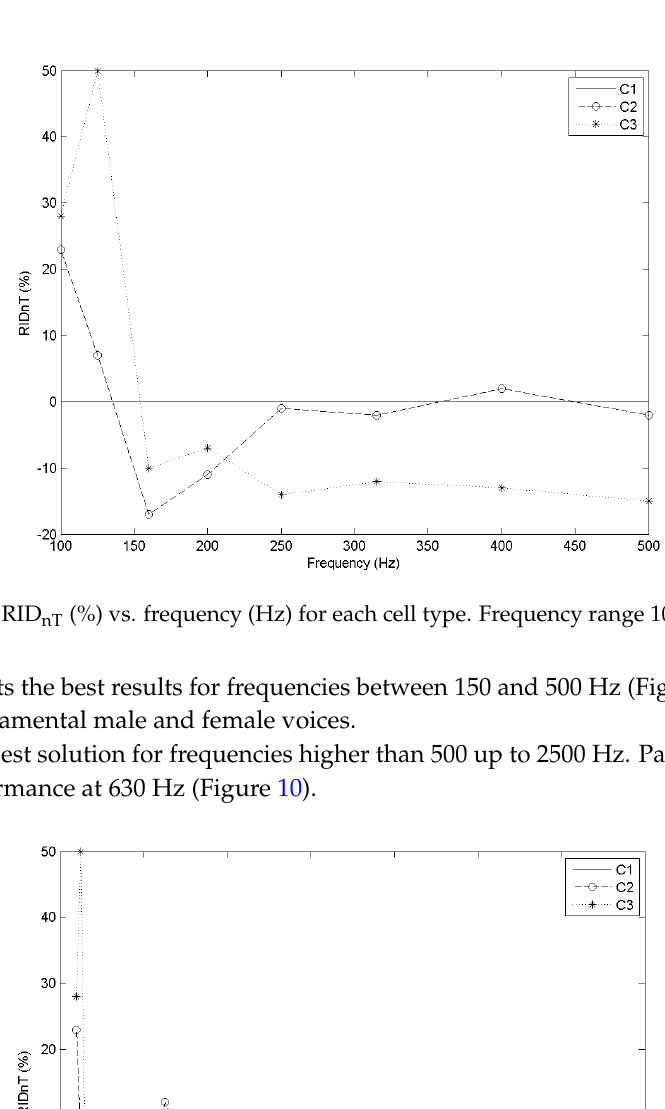
Figure 10. RID nT (%) vs. frequency (Hz) for each cell type.